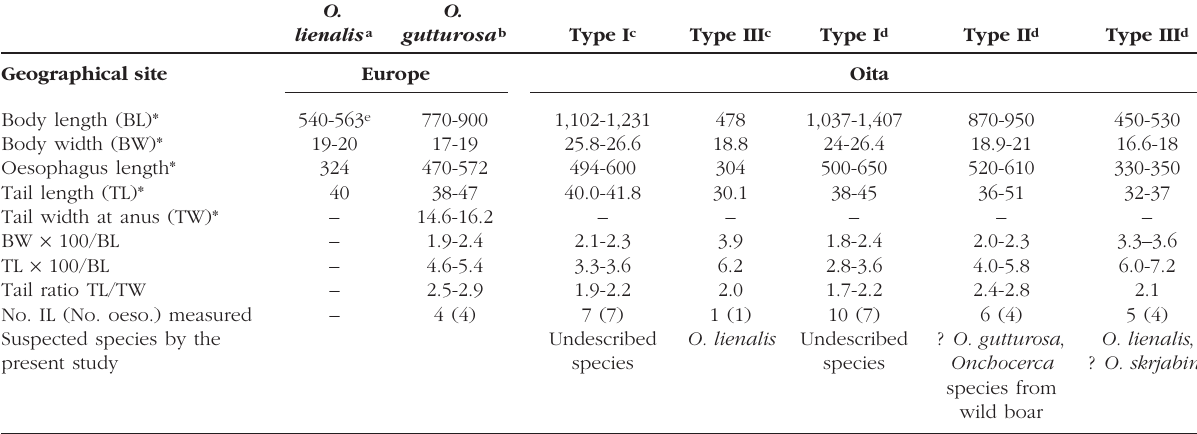
Table VII. – Infective larvae of Onchocerca lienalis and O. gutturosa in Europe and those of filarial species from Simulium spp. in Oita,